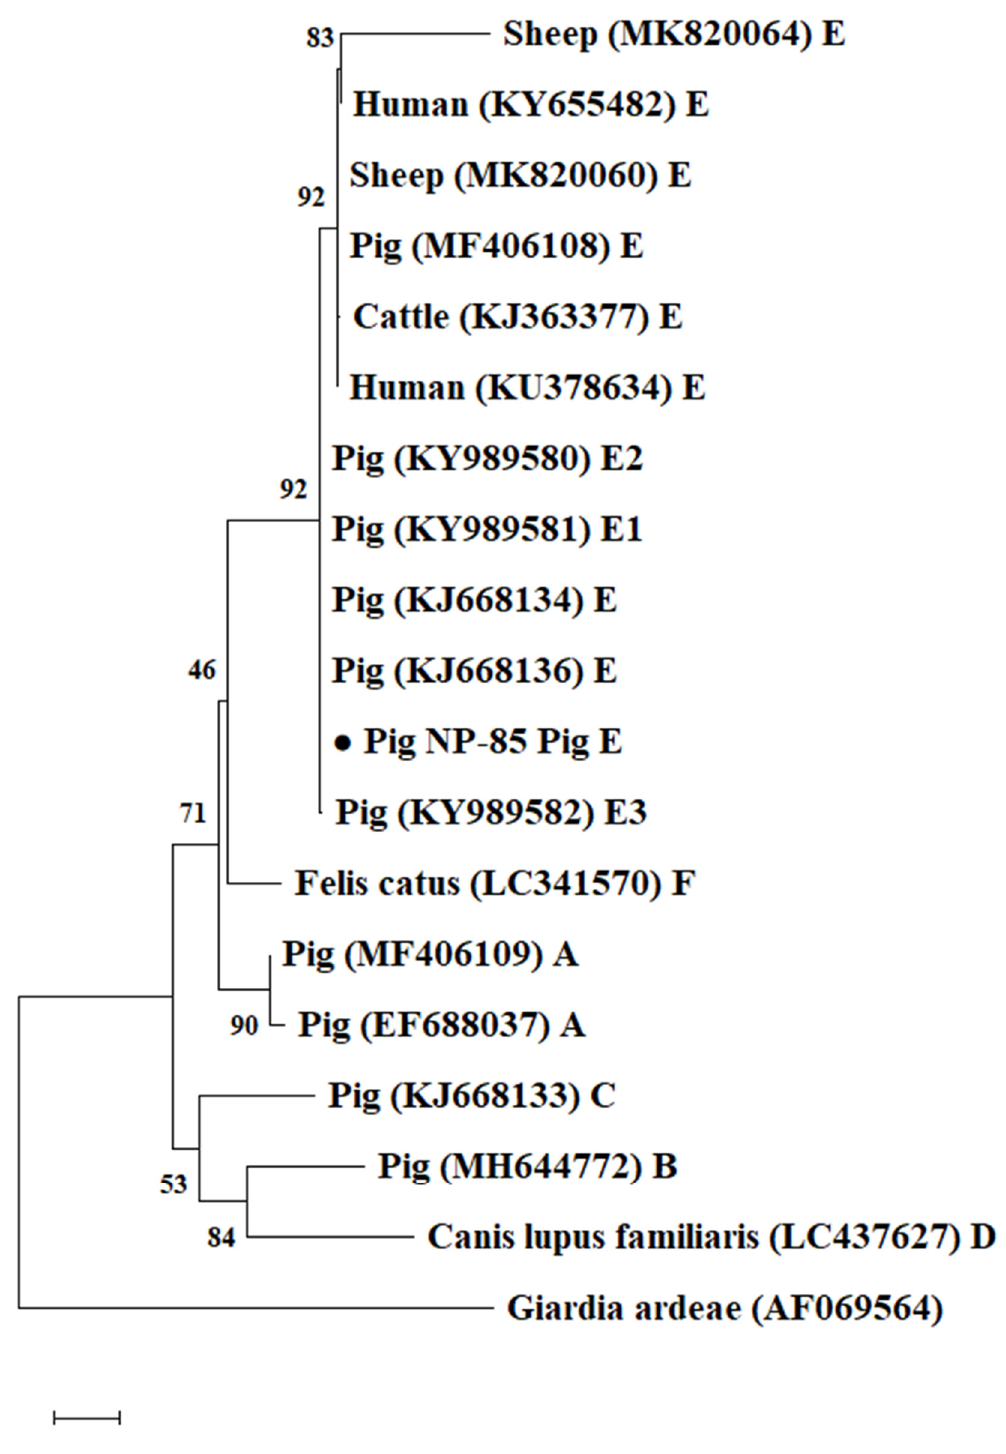
Figure 3. Phylogenetic relationships of Giardia duodenalis isolates obtained using the neighbor-joining analysis of the glutamate dehydrogenase ( gdh ) nucleotide sequences. Bootstrap values >50% from 1000 replicates are shown as nodes. Giardia ardeae was used as outgroup. Filled black circles represent bg sequences generated in this study. The scale bar indicates 0.2 nucleotide substitution/site.